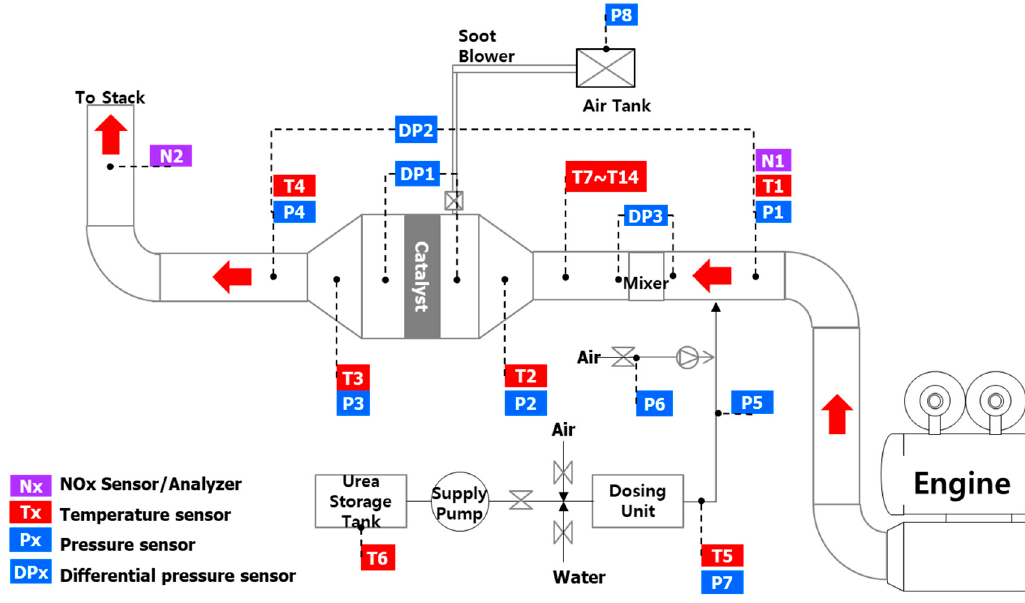
Figure 5. Schematic of the marine engine and engine dynamometer. Table 3. Specifications of the test engine.